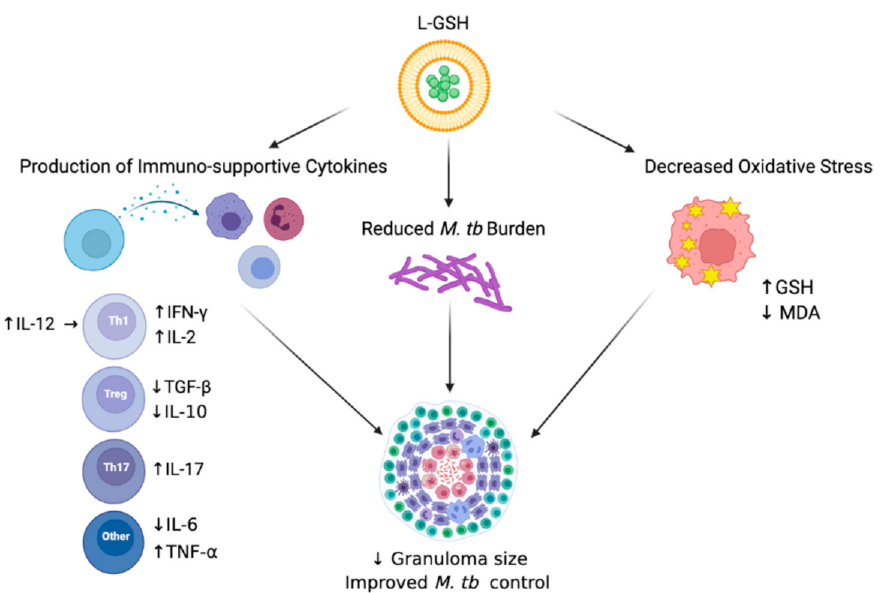
Figure 7. Summary of the results. Treatment of L-GSH was associated with decreased oxidative stress, the induction of a Th1 cytokine response, and reduced M. tb burden in infected mice organs. L-GSH treatment increased the GSH levels and decreased the levels of lipid peroxidation by-product, MDA, resulting from decreased oxidative stress. An increase in IFN- γ , TNF- α , IL-2, IL-12, and IL-17 levels was also noted after L-GSH treatment, while IL-10, TGF- β , and IL-6 levels were decreased in this group. A significant decrease in M. tb CFUs was observed in the lungs after L-GSH treatment. An upward arrow ( ↑ ) resembles an increase; a downward arrow ( ↓ ) resembles a reduction. The figure was created using